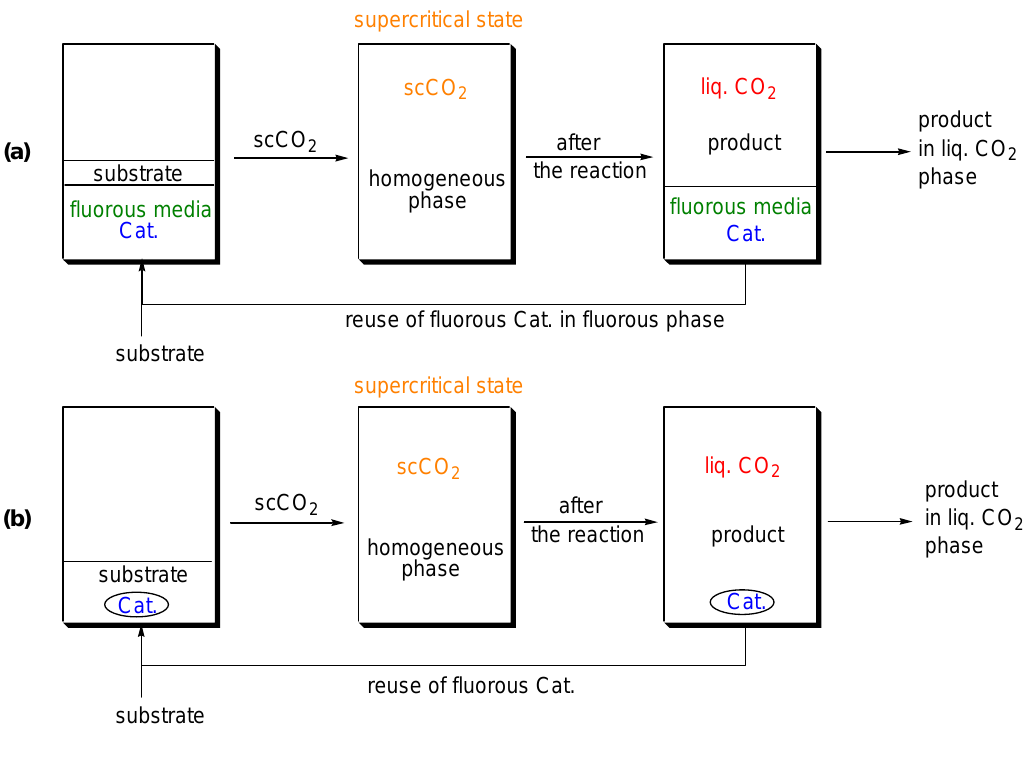
as a reaction 2